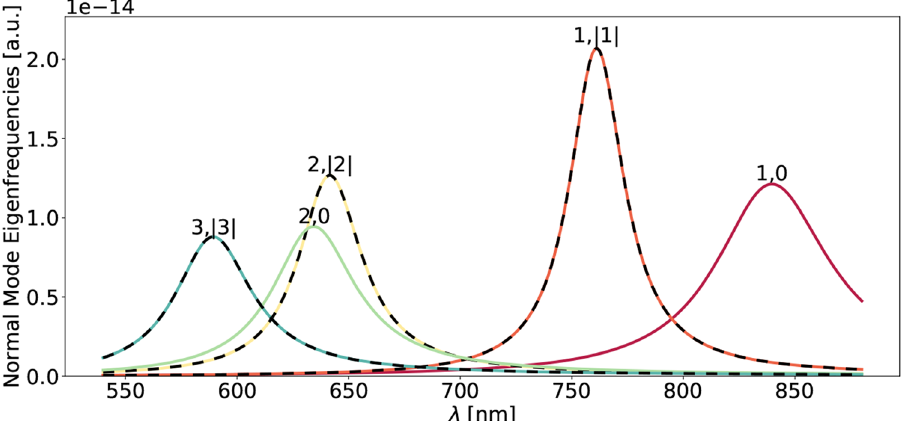
Fig. 3. Faceted spherical NPoM QNM complex eigenfrequencies fi tted to Lorentzians. Dashed lines represent degenerate